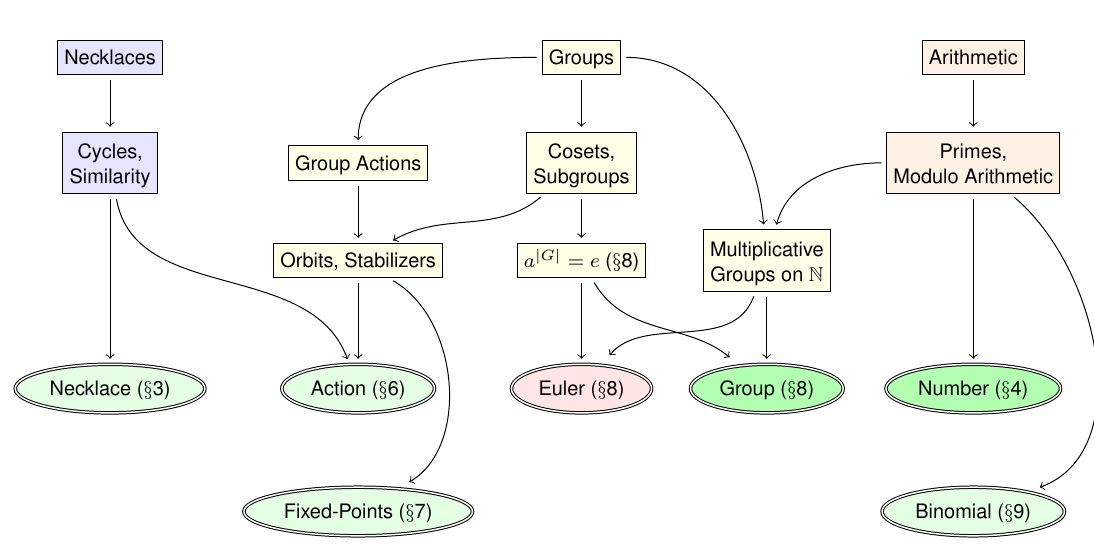
Fig. 1. Theory dependencies for proofs of Fermat’s Little Theorem (FLT). Double-lined ellipses indicate proofs of FLT discussed in the corresponding section of the paper. The leftmost Necklace , rightmost Number and Binomial are direct proofs; others use group theory. Binomial and combinatoric results (in light green) are of the form a p ≡ a (mod p ) , which is equivalent (when 0 < a < p for prime p , see Theorem 9 and its footnote) to number-theoretic results (in dark green) of the form a p − 1 ≡ 1 (mod p ) . Euler (in light red) is of the form a ϕ ( n ) ≡ 1 (mod n )